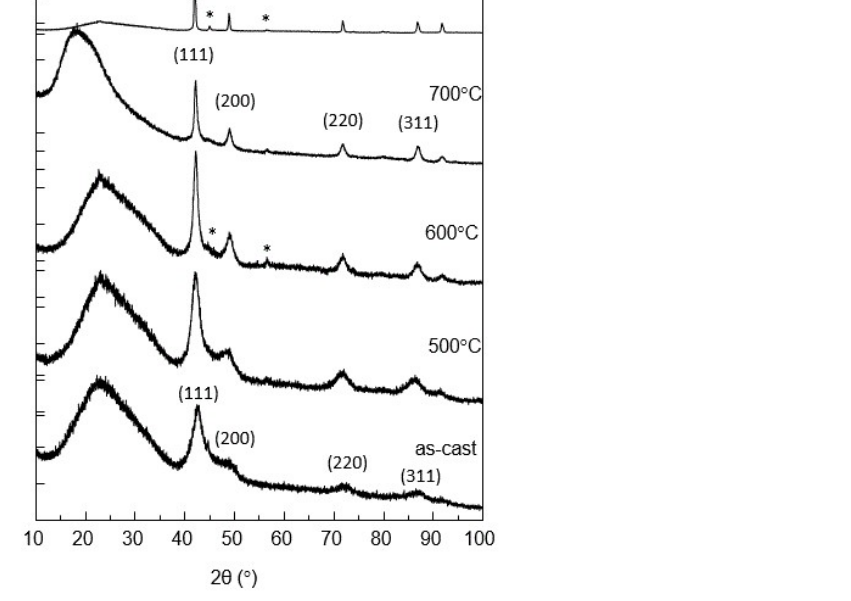
Figure 1. XRD patterns of the samples as ‐ cast and annealed at 500°C to 800°C. Table 1. The lattice parameters and the average grain sizes derived from the fit of the XRD spectra.